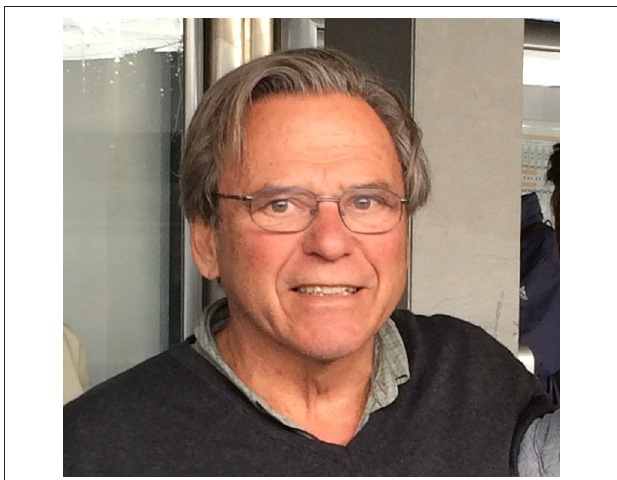
FIGURE 2 | Ricardo González.